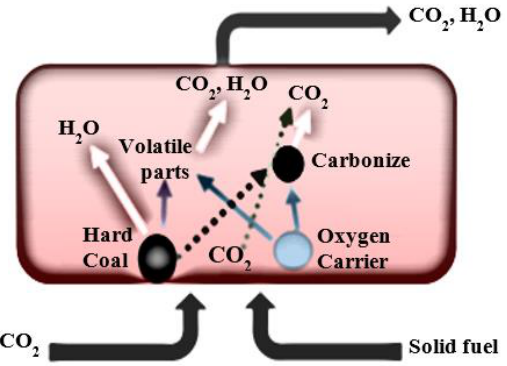
Figure 1. The scheme of the oxygen release process from the CLOU type of the oxygen carrier in the fuel reactor.